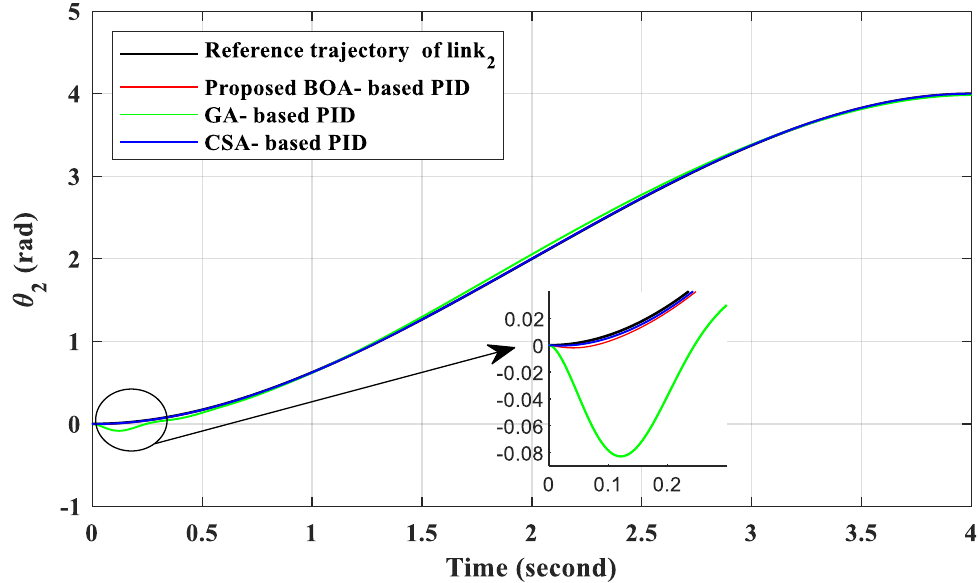
Figure 10. The output position due to link 2 in the case of cubic reference.